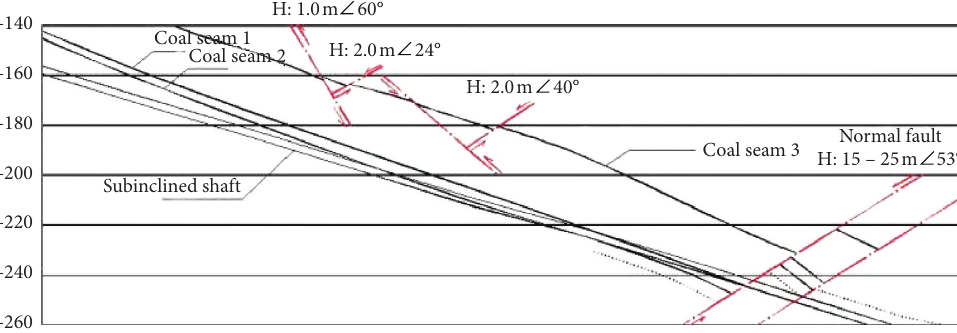
Figure 4: The space position relationship between the subinclined shaft and coal seam.